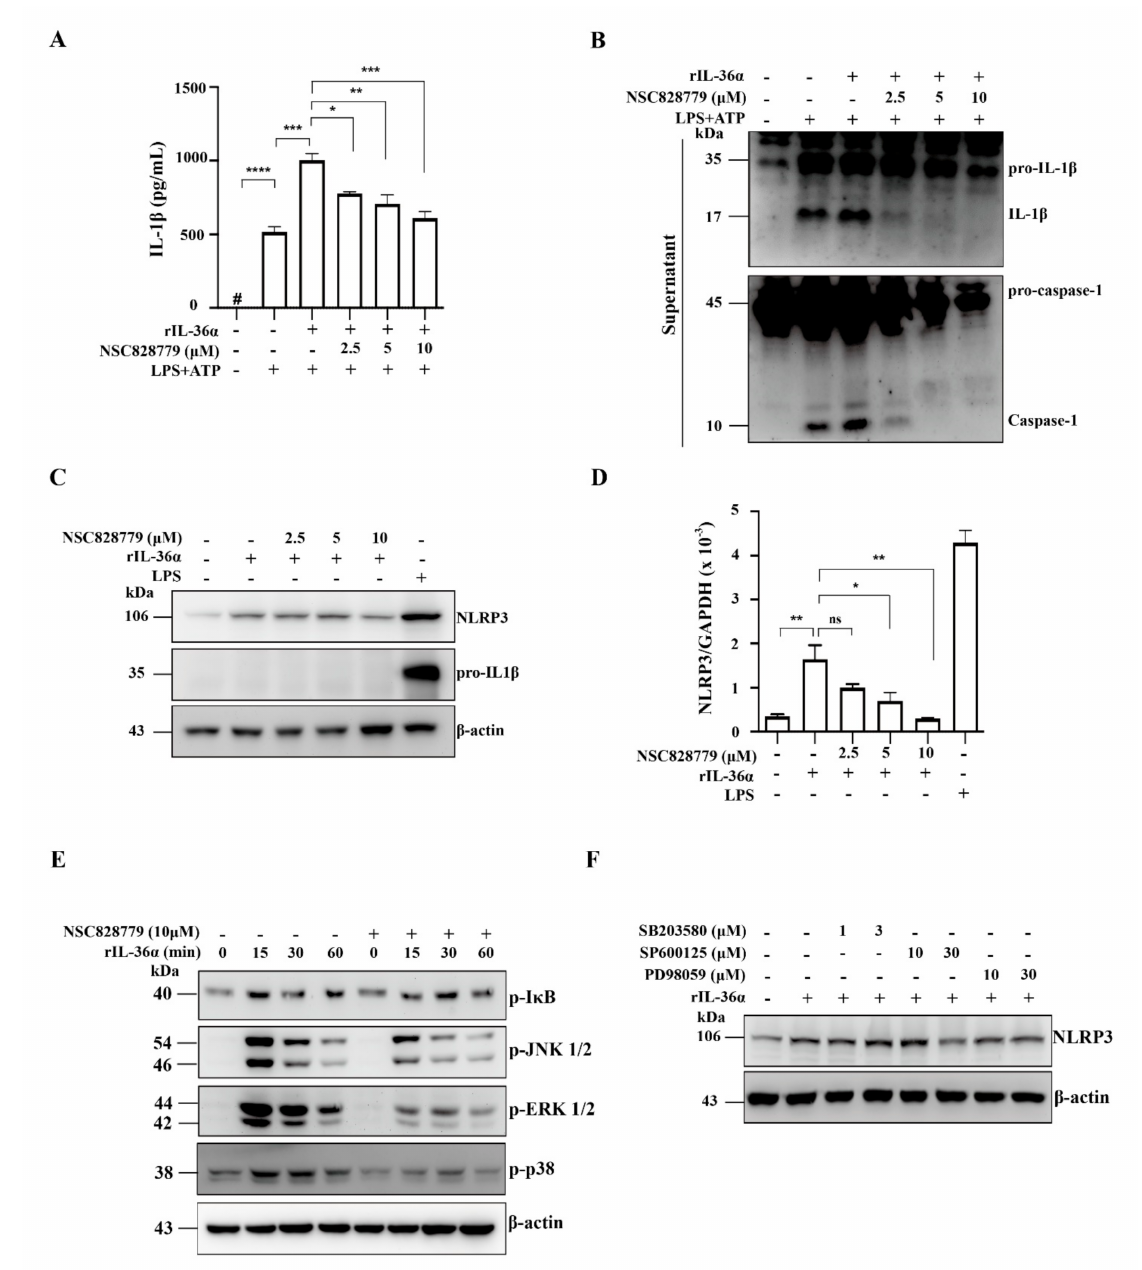
Figure 5. NSC828779 inhibits NLRP3 inflammasome activation in IL-36a-primed macrophages. J774A.1 macrophages were incubated for 30 min with or without NSC828779, then for 0.5 h rIL-36 α with 0.5 µ g/mL of LPS, with or without 5 mM ATP (30 min) for IL-1 β levels ( A ) in culture media measured using ELISA or ( B ) IL-1 β , caspase-1 by Western blot analysis. Cells were incubated for 30 min with or without NSC828779 and 6 h with or without 150 ng/mL of IL-36 α for Western blots of ( C ) NLRP3 and pro-IL-1b or real-time PCR for mRNA levels of NLRP3 ( D ). Cells were incubated with for 30 min with or without NSC828779, then with rIL-36 α for 15, 30, or 60 min. ( E ) Phosphorylated IkB, ERK1/2, JNK1/2, and p38 in cell lysates, measured by Western blot analysis. (F) Levels of NLRP3 in cell lysates by Western blot analysis. J774A.1 macrophages were incubated for 0.5 h with PD SP or SB, followed by incubation for 5.5 h with IL-36 α at 150 ng/mL. Data represent three separate experiments. Data are shown as means ± SEM for three separate experiments, and each experiment was performed in triplicate. NSC828779, a salicylanilide derivative. PD98059, an inhibitor of p-ERK1/2. SB203580, an inhibitor of p-JNK1/2. SP600125, an inhibitor of p-p38. # not detectable. ns, no significant difference. * p < 0.05, ** p < 0.01, *** p < 0.005, **** p <